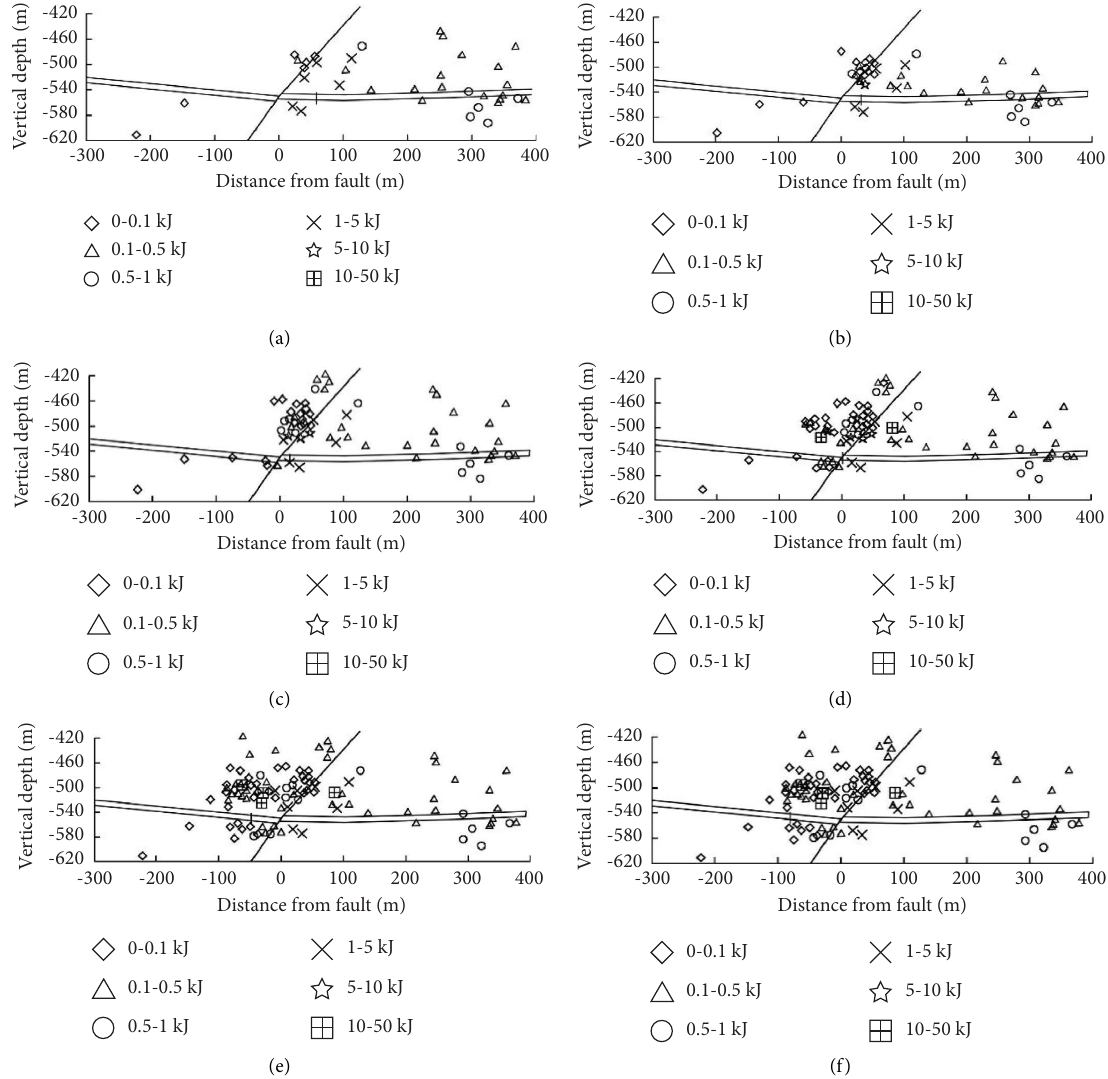
Figure 2: Seismic origin when caving pass through fault. (a) Distance of fault to working face is 62m on July 26th. (b) Distance of fault to working face is 39m on August 1st. (c) Distance of fault to working face is 18 m on August 6th. (d) Distance of fault to working face is 0m on August 11th. (e) Distance of fault passing through the working face is 47m on August 17th. (f) Distance of fault passing through the working face is 80m on August